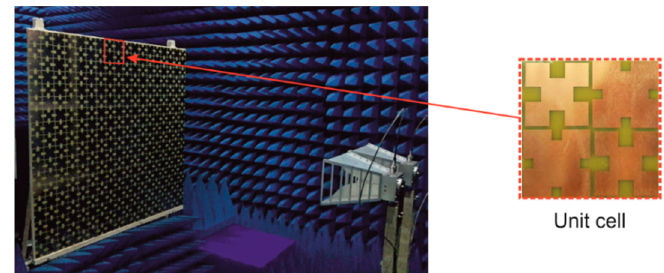
Figure 6. Free-space measurement setup with a particular of the fabricated MA absorber.